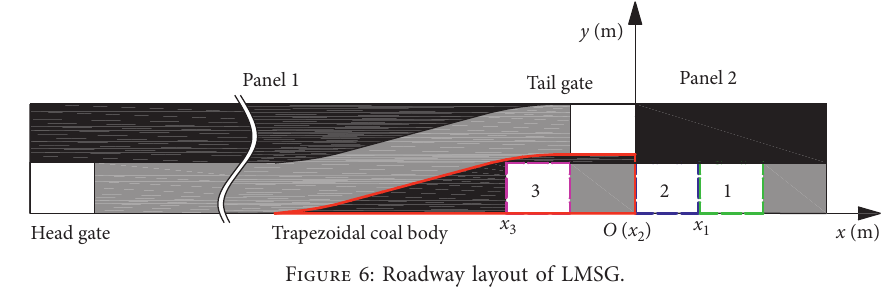
Figure 6: Roadway layout of LMSG.